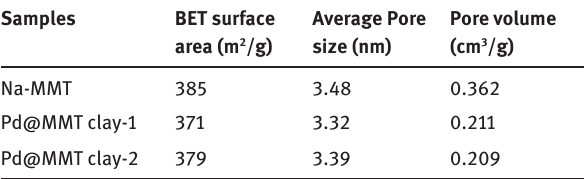
Table 1: Surface properties of Na-MMT clay and Pd@MMT clays. Samples